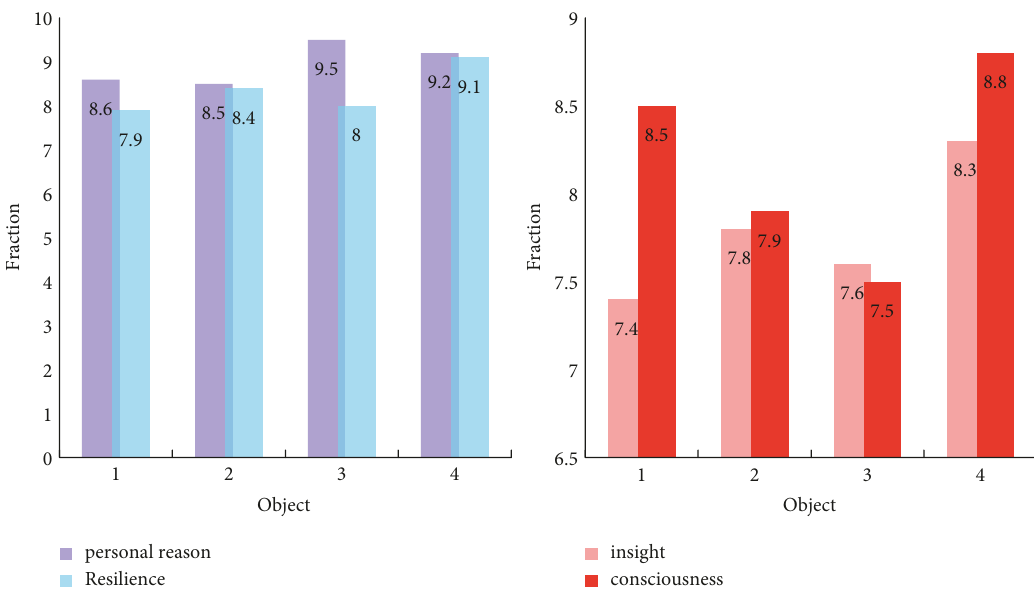
Figure 9: Characteristics of successful